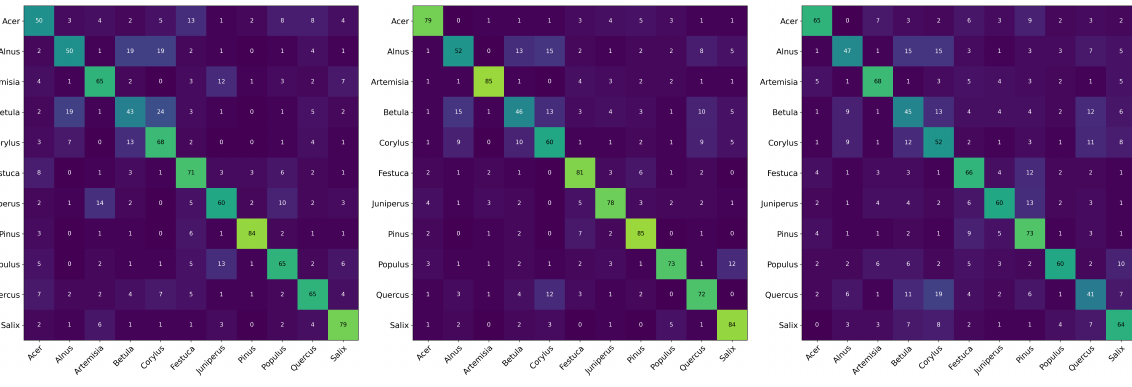
Figure 9. Confusion matrix created on the test set from the SAU-LI dataset with feature extractor classification; from left to right: scattering, spectrum and lifetime. Values are